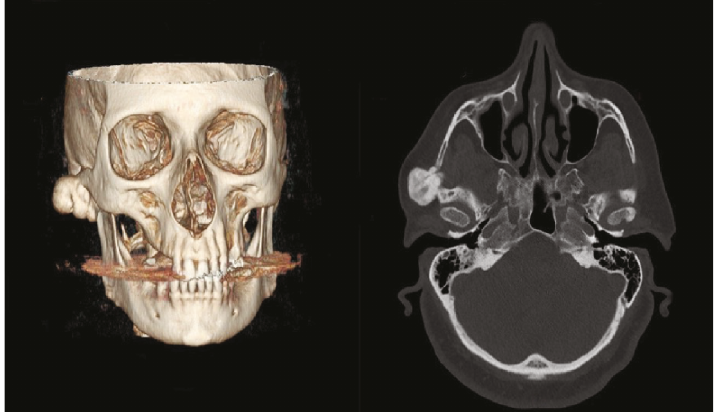
Figure 2: Axial CT scan and three-dimensional reconstruction image showing a well-de fi ned, pedunculated, and radiopaque mass of the right zygomatic arch.